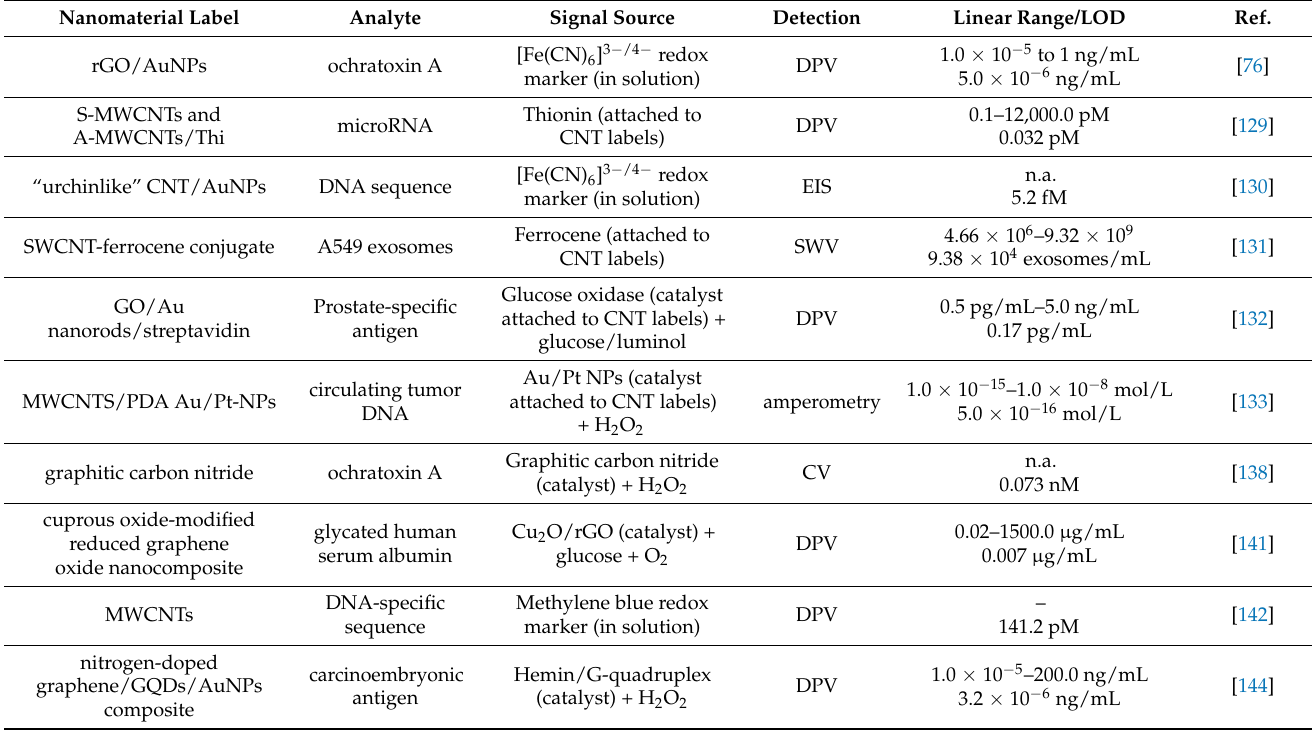
Table 4. Examples of application of carbon nanomaterials as electrochemical